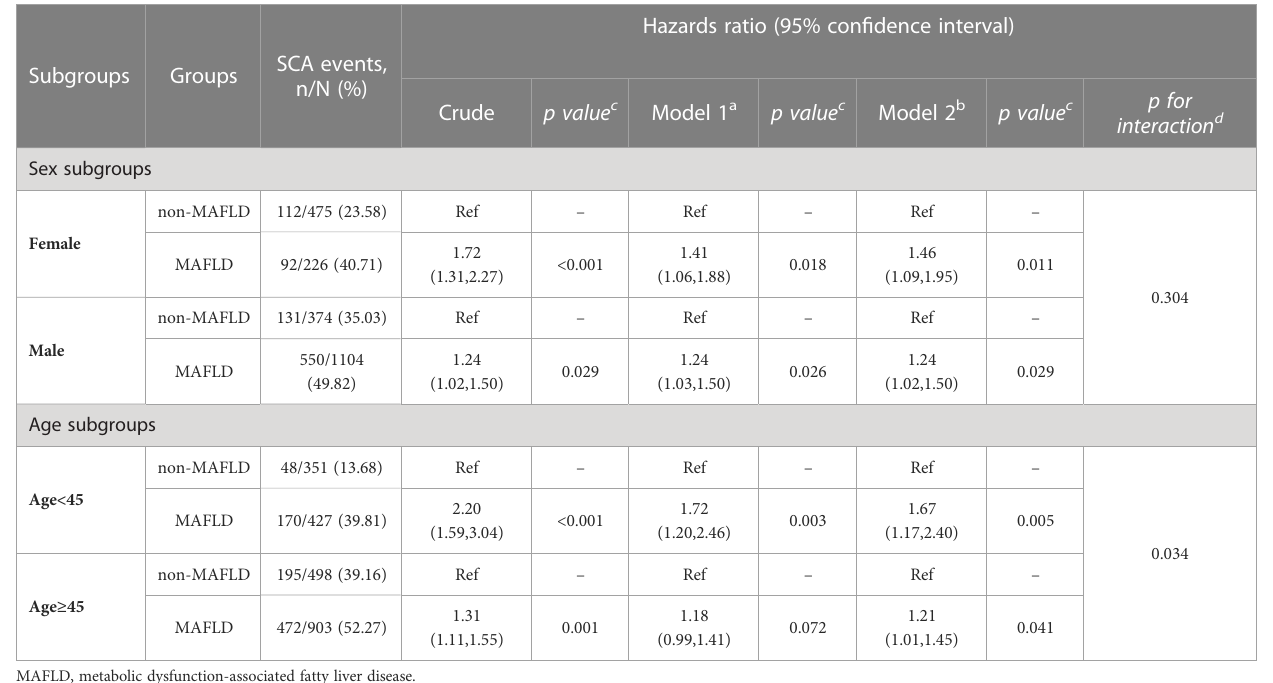
TABLE 5 Association between baseline MAFLD and the subclinical carotid atherosclerosis in the cohort subgroups.